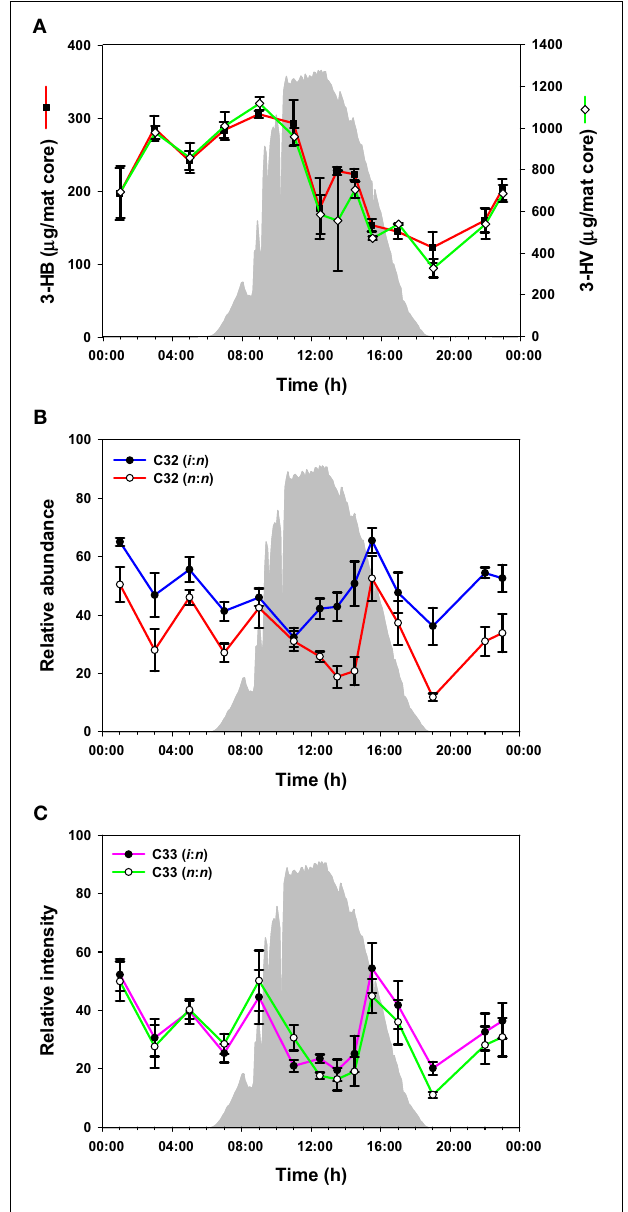
FIGURE 4 | PHAs and wax esters over the diel cycle. Solar irradiance (solid gray) and amount of monomers from hydrolysis of PHAs (A) ; C 32 wax esters (B) ; C 33 wax esters (C) . Metabolite values plotted are mean ± standard error ( n = 3